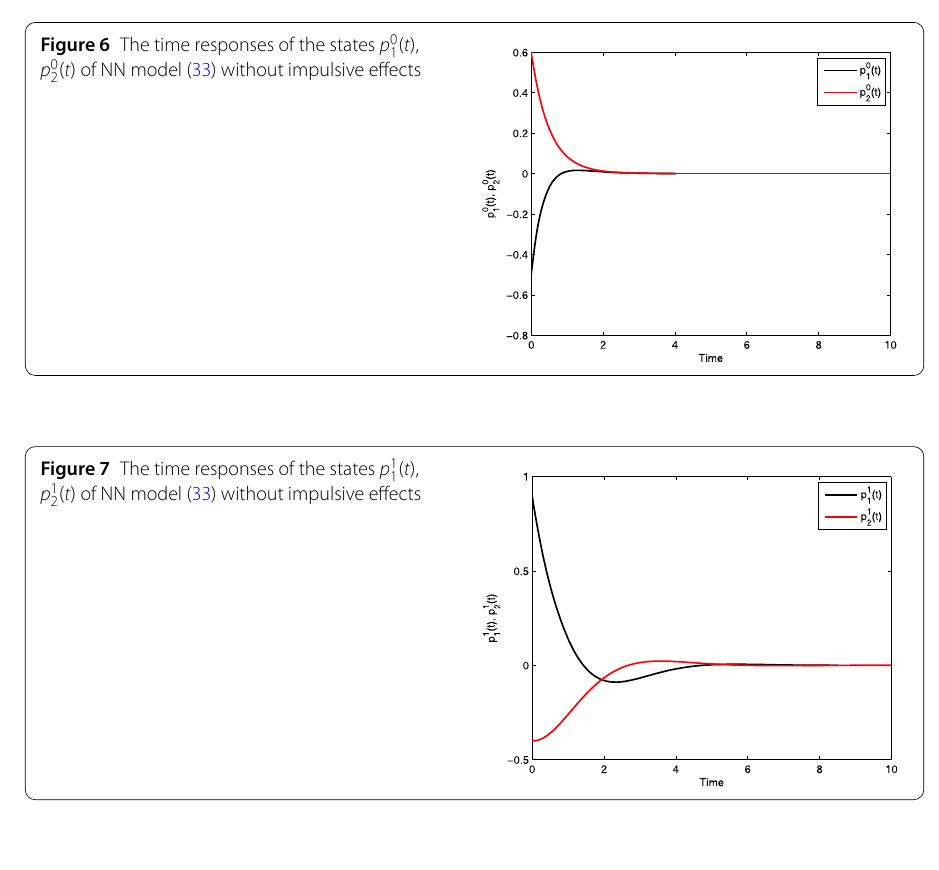
Figure 8 The time responses of the states p 2 1 ( t ), p 2 2 ( t ) of NN model (33) without impulsive effects